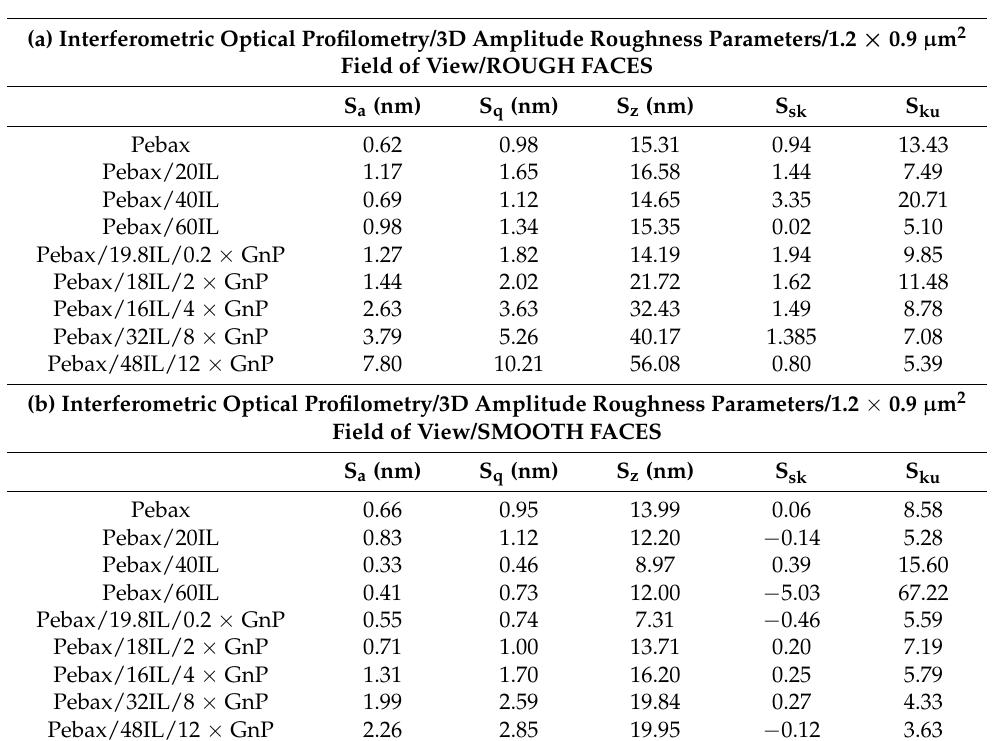
Table 4. Interferometric optical profilometry of the (a) rough and (b) smooth faces of the mem- branes